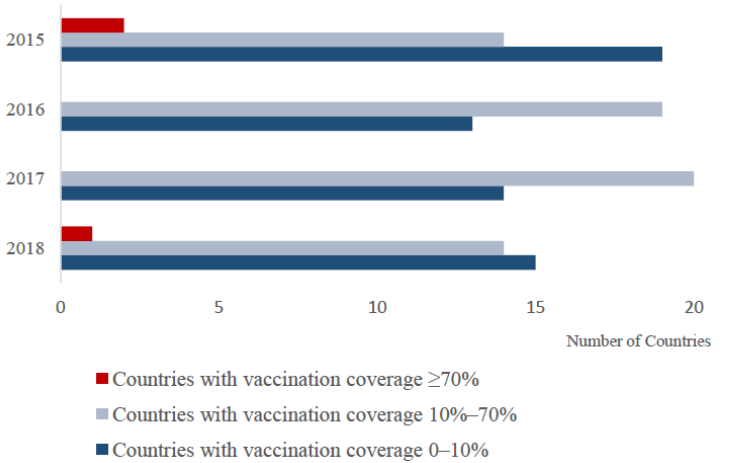
Figure 1. The number of countries with different vaccination coverage percentages for which data were available. Vaccination coverage is estimated by dividing the number of vaccine doses used (derived from WAHIS) by the number of goats and sheep in the country (derived from FAO-STAT).